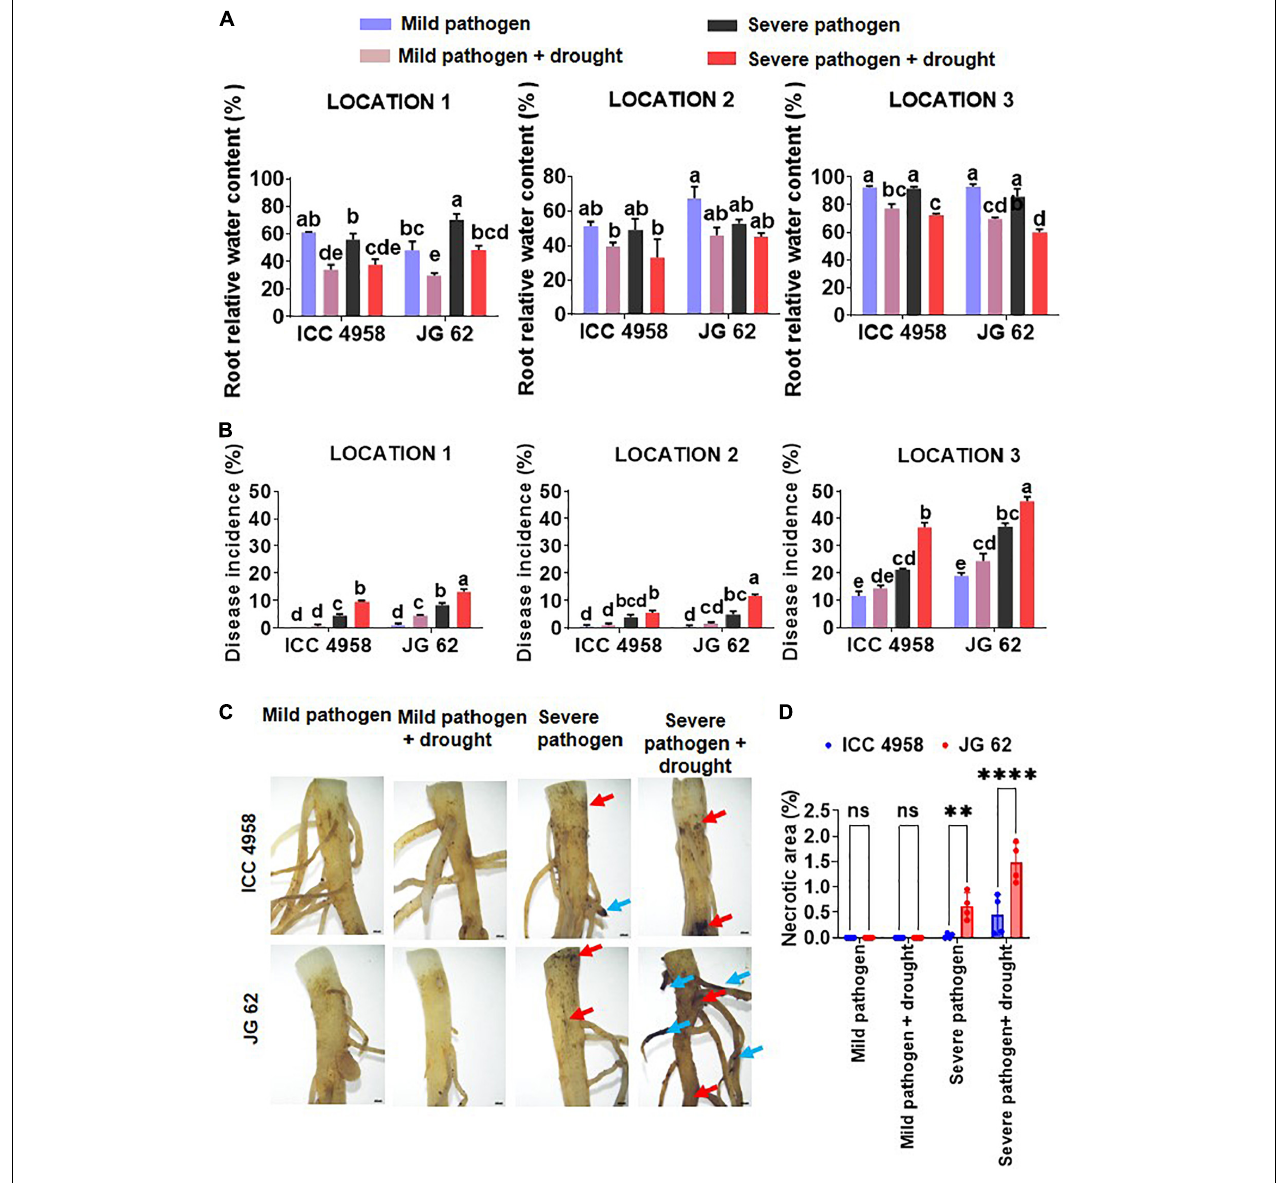
FIGURE 1 | On-season field trials exhibiting the influence of plant-water relations in dry root rot (DRR) disease aggravation. The four treatments considered were- mild pathogen (fields frequent irrigated to maintain 80% FC and treated with appropriate fungicide), mild pathogen + drought (less frequently irrigated fields to maintain 50% FC and treated with appropriate fungicide), severe pathogen (frequently irrigated fields to maintain 80% FC without any fungicide application), severe pathogen + drought (less frequently irrigated fields to maintain 50% FC without any fungicide application) for both the genotypes ICC 4958 and JG 62. (A) Root relative water content of the two contrasting chickpea genotypes under different stress and their combinations across different experimental locations. The bars in the following graphs are the averages of their respective block replicates with standard error as error bars. Under field conditions, we did not observe a non-symptomatic control plot as the minor infection was reported in the control (fungicide treated) plot as well. This treatment is mentioned as a “mild pathogen”. (B) The disease incidence data, was collected at the late podding stage and additionally at the harvest stage from plants with symptomatic roots for confirmation from three locations under different stress treatments. The bars in the following graphs are the averages of their respective block replicates with standard error as error bars. (C) Root images showing the root branching zone 1 of 29 days old JG 62 and ICC 4958 plants exposed to a mild pathogen, severe pathogen, mild pathogen + drought, severe pathogen + drought, for 10 days under greenhouse conditions. The dark-colored lesions show the severity and higher infection in JG 62 over ICC 4958. Root images were captured under 0.63X objective lens of SMZ25 research stereomicroscope. Blue arrows show the necrotized lateral roots. Red arrows indicate the necrotic spots. The details of the locations are provided in Supplementary Table 2 . Statistical significance between means was checked by two-way ANOVA and Tukey’s Posthoc test. The different letters denote a significant difference between mean at p < 0.05. (D) Graph represents the root necrosis area (%) of two cultivars for different treatments mild pathogen, severe pathogen, mild pathogen + drought, severe pathogen + drought. The bars on the graph indicate the averages of different treatments for 4 replicates with standard error as an error bar. Statistical significance difference between means is checked by two-way ANOVA and sidak’s mean multiple comparison test. The ∗∗ p < 0.01, ∗∗∗∗ p < 0.0001., ns, non-significant.